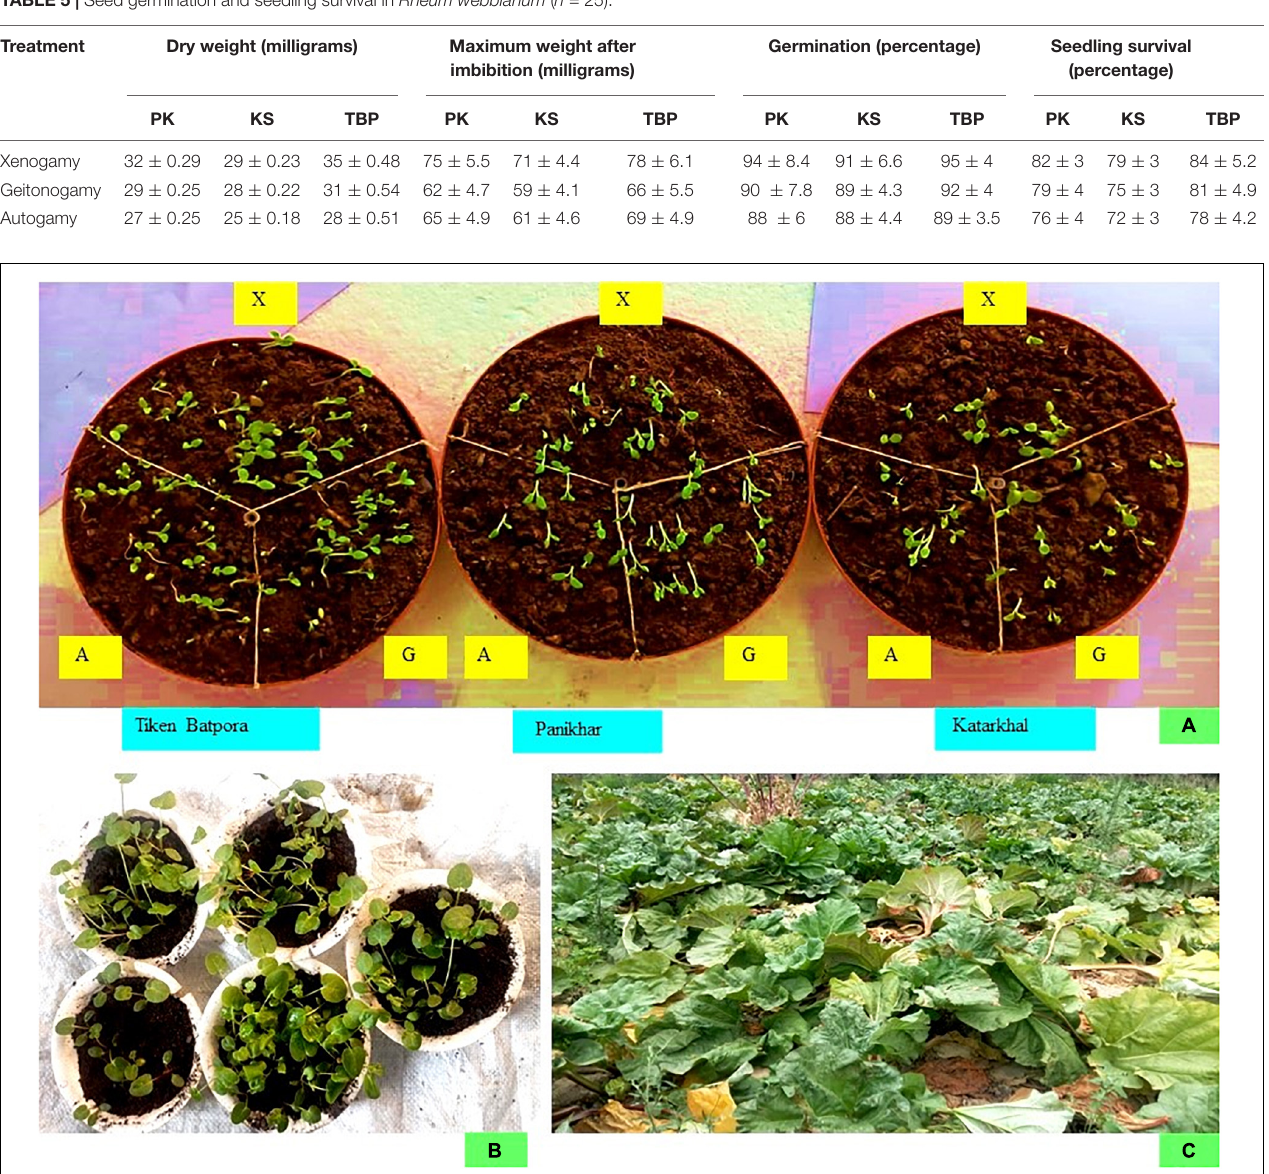
FIGURE 9 | Seed germination and seedling transplantation. (A) Seed germination results of the seeds obtained from manual treatments X, xenogamy; G, geitonogamy; A, autogamy. (B) Root hardening. (C) Transplanting the plants into field conditions.